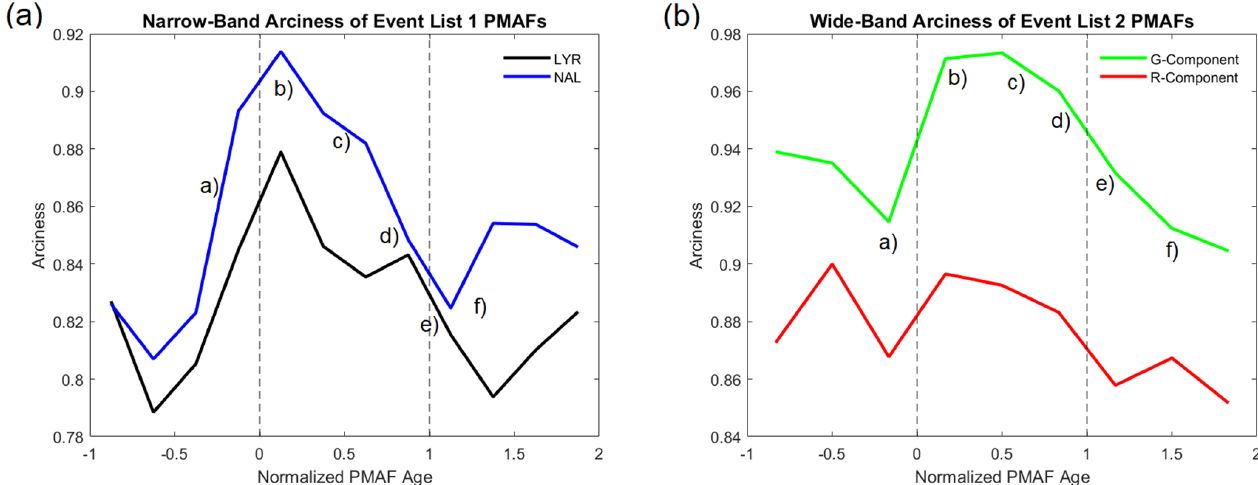
Figure 6. Superposed epoch analysis (SEA) of arciness for several PMAF events. (a) Narrow-band arciness calculated from ASC images taken in Ny-Ålesund – NAL (red) and Longyearbyen – LYR (blue). (b) Green and red wide-band arciness from the KHO ASC images. The letter labels (a) – (f) approximately correspond to the different evolutionary steps in Fig. 7 with the same labels.